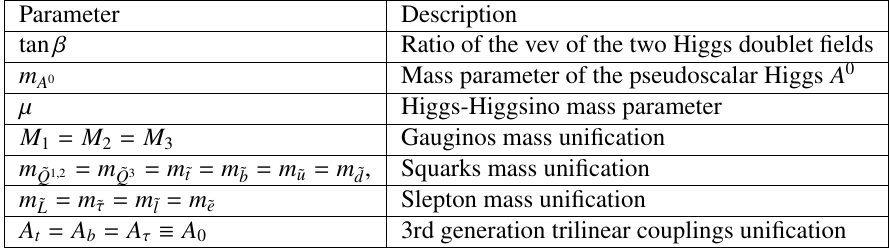
Table 1: Additional free parameters in the phenomenological